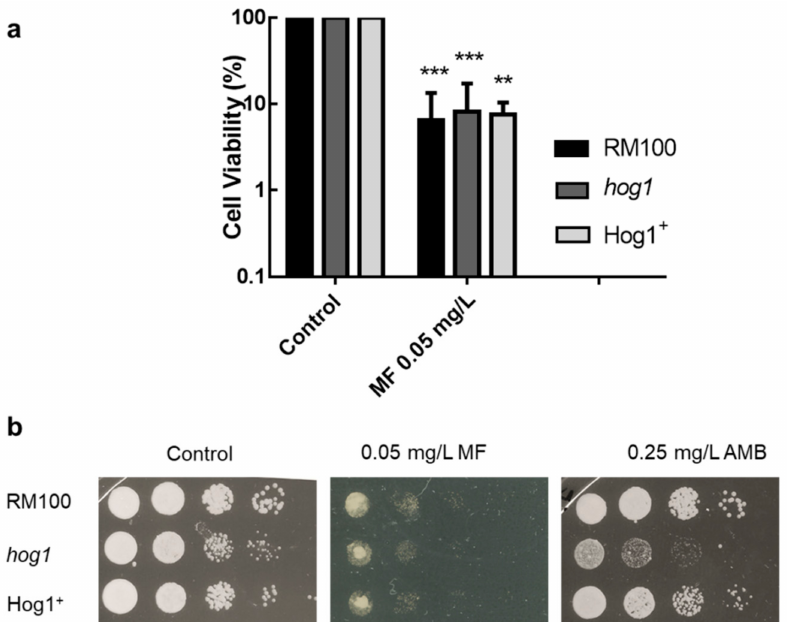
Figure 1. Sensitivity displayed by the hog1 null mutant to antifungal exposure with micafungin (MF) and osmotic stress. ( a ) Strains RM100 (black histograms), hog1 (dark-grey histograms), and Hog1 + (light-grey histograms) were treated with 0.05-mg / L MF or 0.25 mg / L Amphotericin B (AMB) for 1 h in liquid yeast extract peptone dextrose (YPD) at 37 ◦ C. The cells were then collected and spread on YPD plates, and cell viability was determined by colony-forming unit (CFU) counting. The data shown are the mean ± SD of three independent experiments. ** p < 0.01 and *** p < 0.001 represent statistically significant di ff erences with respect to an untreated control, according to the Mann Whitney U test. ( b ) Ten-fold cell suspensions were spotted on YPD plates containing MF and AMB. The plates were incubated at 37 ◦ C for 24